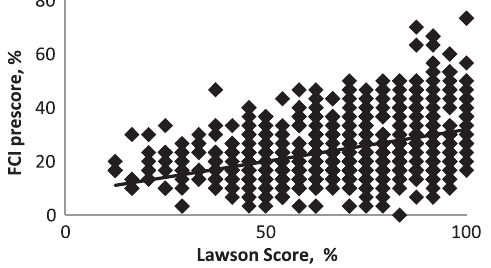
FIG. 7. Individual data for 803 students at Arizona School for the Arts, 2007 – 2018 ( r ¼ 0 . 39